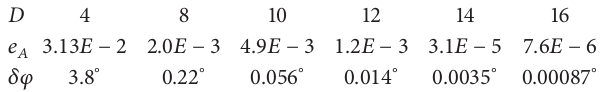
Table 1: Possible phase errors caused by ADC.